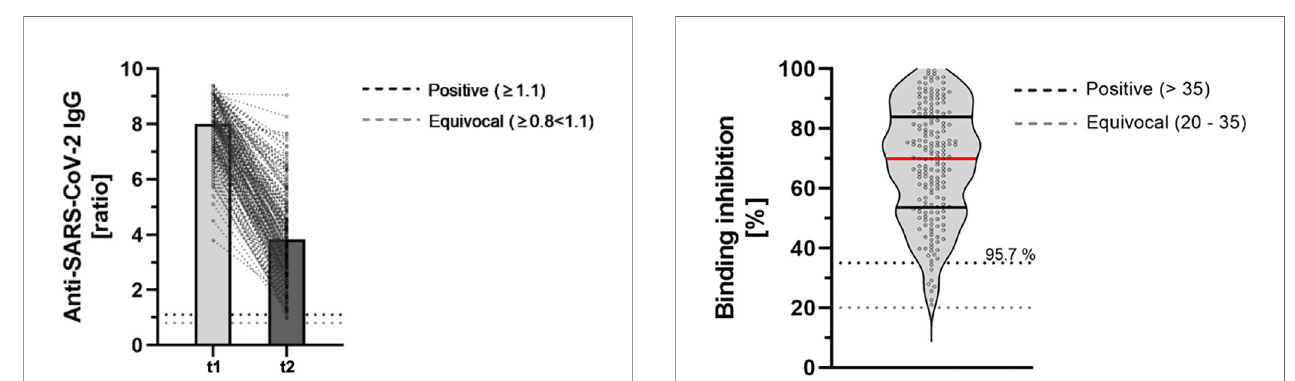
FIGURE 3 | Binding inhibition capability of neutralizing antibodies 9 months after vaccination with BioNTech/P fi zer vaccine BNT162b2. Neutralizing anti- SARS-CoV-2 antibodies were determined using the NeutraLISA ™ SARS- CoV-2 Neutralization Antibody Detection KIT from Euroimmun. According to the manufacturer, binding inhibition values above 35% were considered positive (horizontal black dotted line), whereas values between 20% and 35% were considered equivocal (horizontal gray dotted line). Red line marks the mean. The dashed lines show the positive (light gray)- and equivocal (dark gray) cutoffs speci fi ed by the manufacturer.